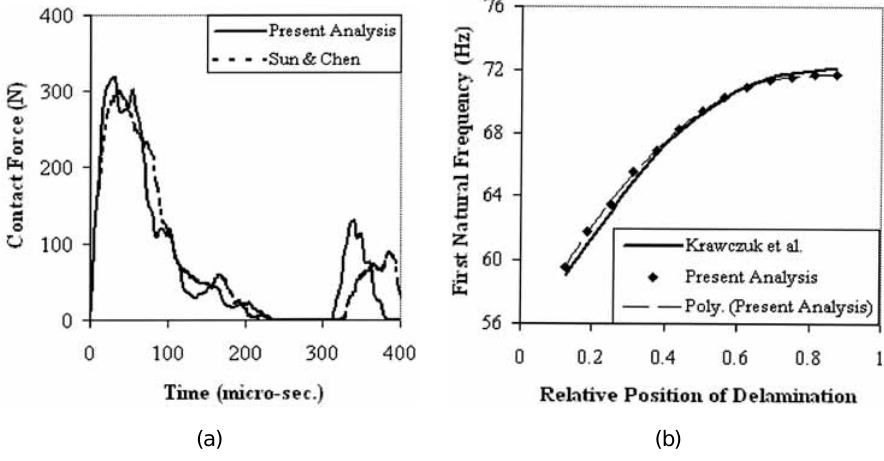
Fig. 3. (a) The contact force of centrally impacted cross ply ([0/90/0/90/0] S ) composite plate under simply supported boundary condition. (b) The influence of the relative position of the delamination on the first natural frequency of the composite cantilever